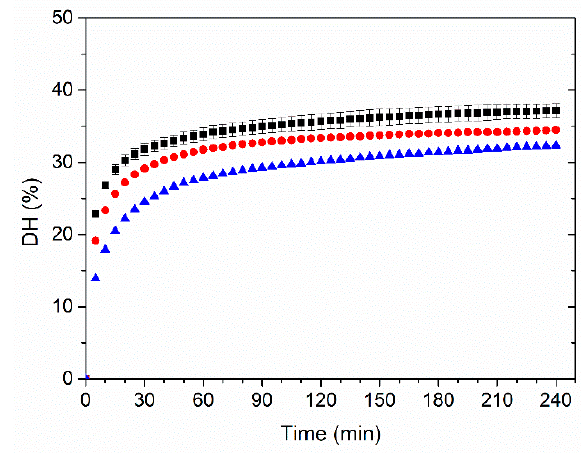
Figure 10. Profile of hydrolysis of casein (26 g/L) at 50 °C, pH 6.5 and 500 rpm stirring catalyzed by free NPD at different loads (g protein/L reactor): ( ■ ) 0.78, ( ● ) 0.26 and ( ▲ ) 0.08.